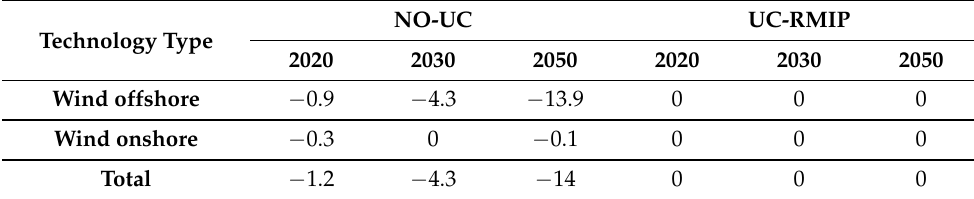
Table 3. Influence of UC approach in aggregated yearly curtailment per technology type in the countries in focus. The difference with respect to UC-MIP approach